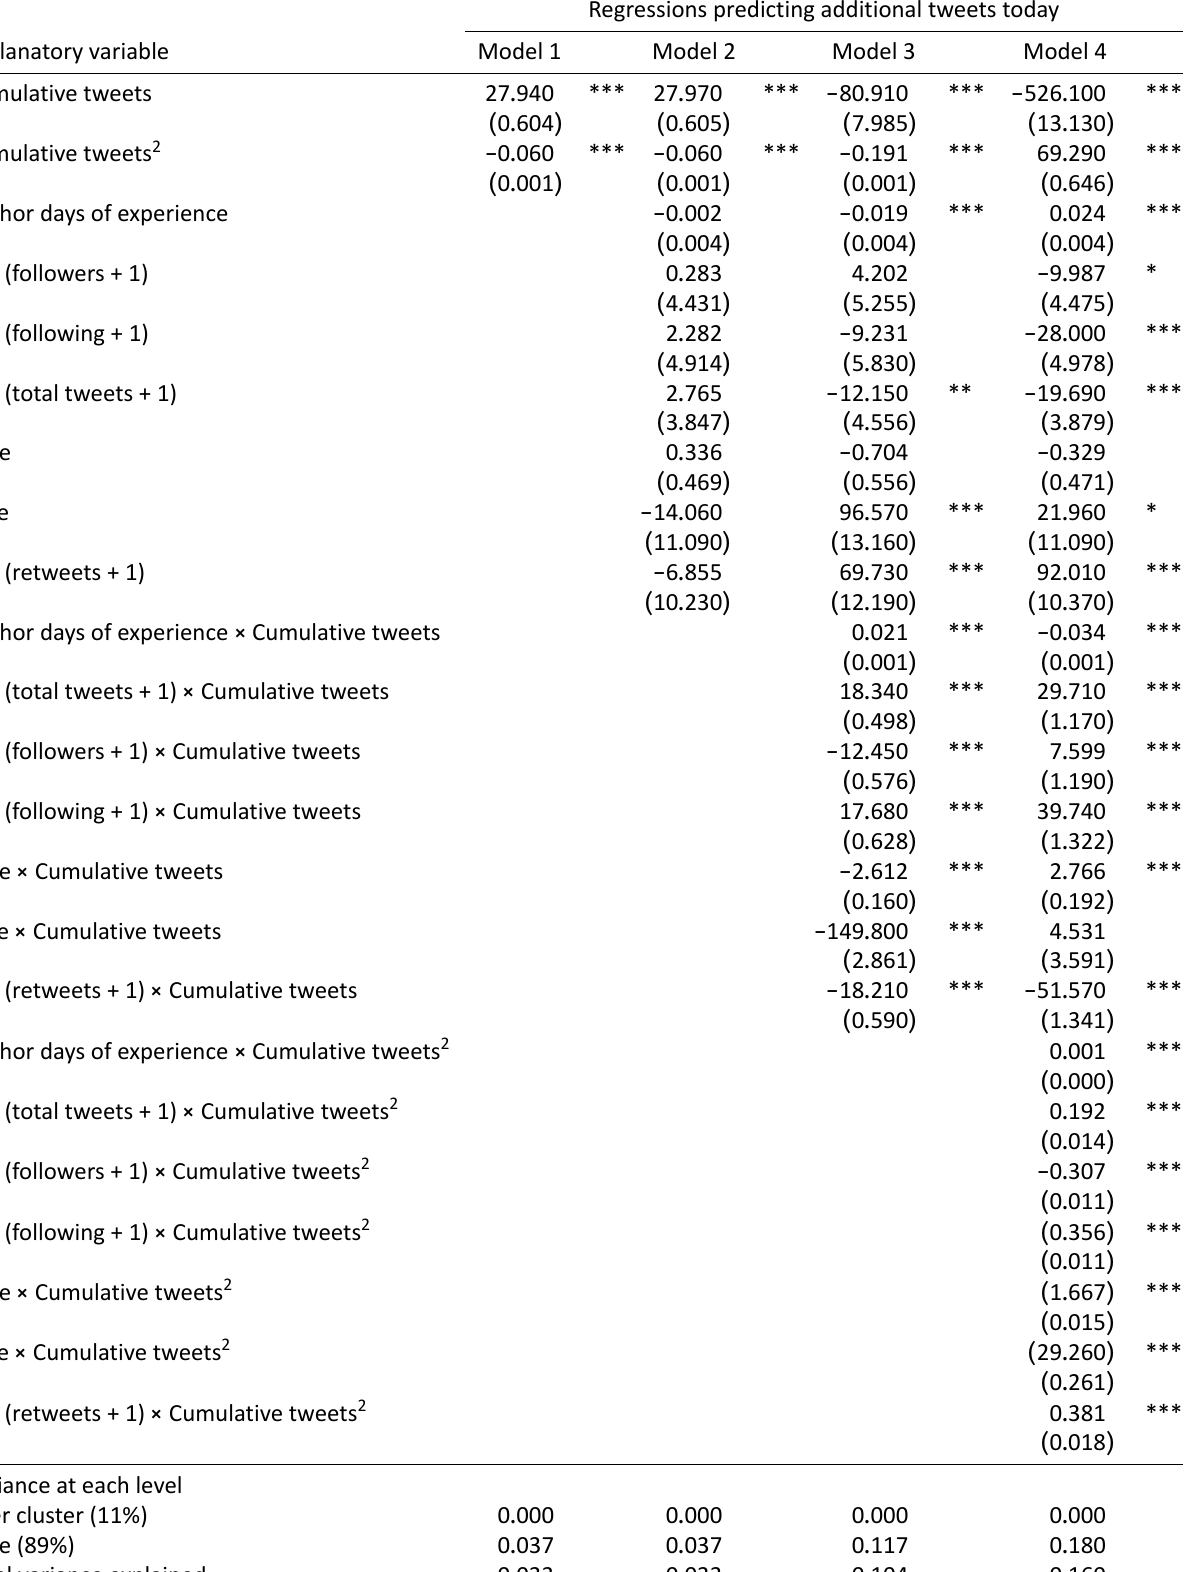
Table 7. MDA results (with 1,000